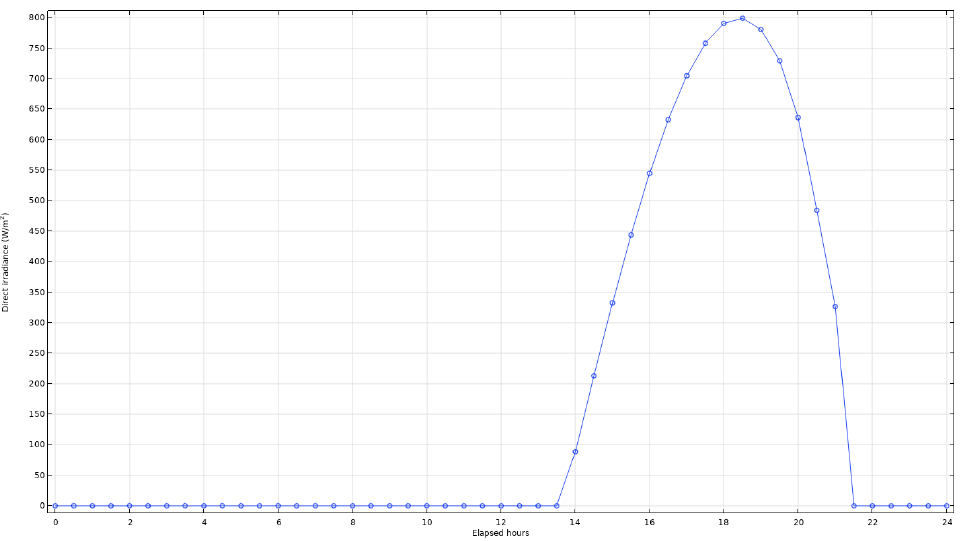
Figure 10. Direct Irradiance (Wm − 2 ) received by the cell at 2019’s summer solstice, referent to the boom’s west